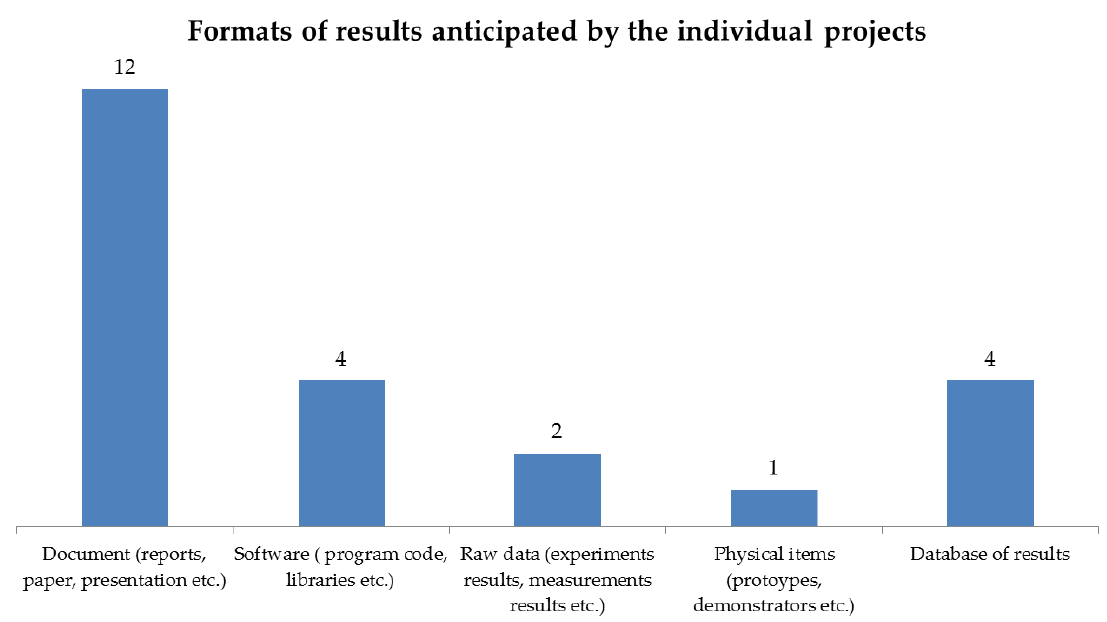
Figure 1. Excerpt of survey results: most results were planned to be published as scientific papers.